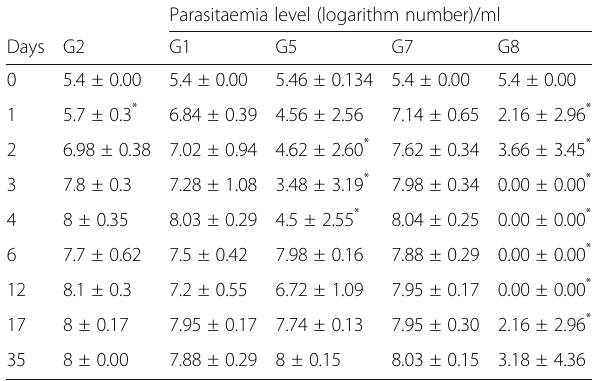
Table 1 Effect of extract of C. swynnertonii on parasitaemia in mice infected with T.